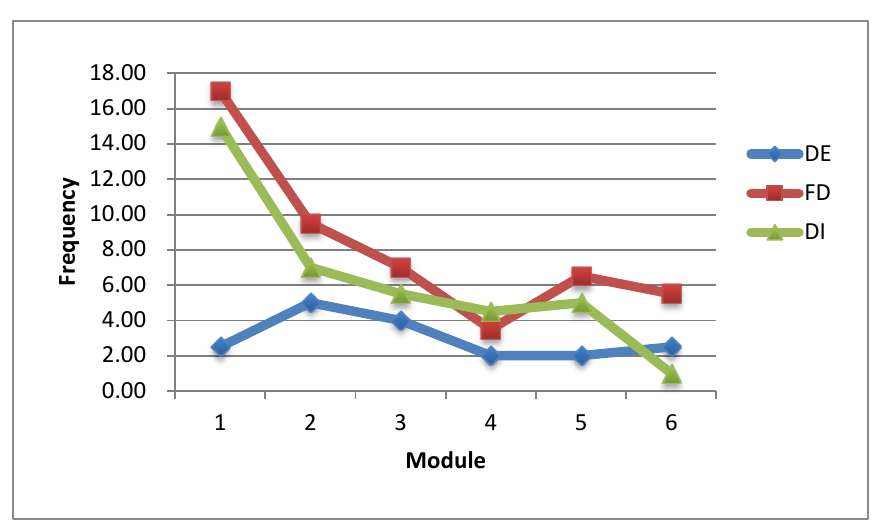
Figure 6. Tutor's teaching presence in each module.